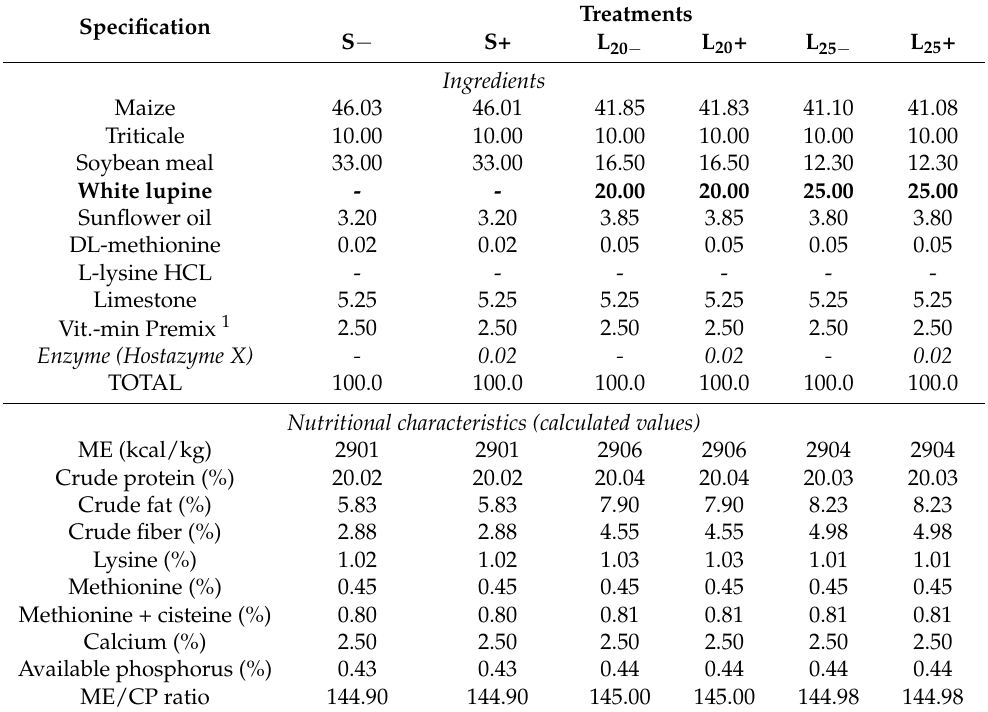
Table 1. Ingredients and nutritional characteristics of diets used in the laying quails’ feeding experi- mental procedure (as-fed basis,